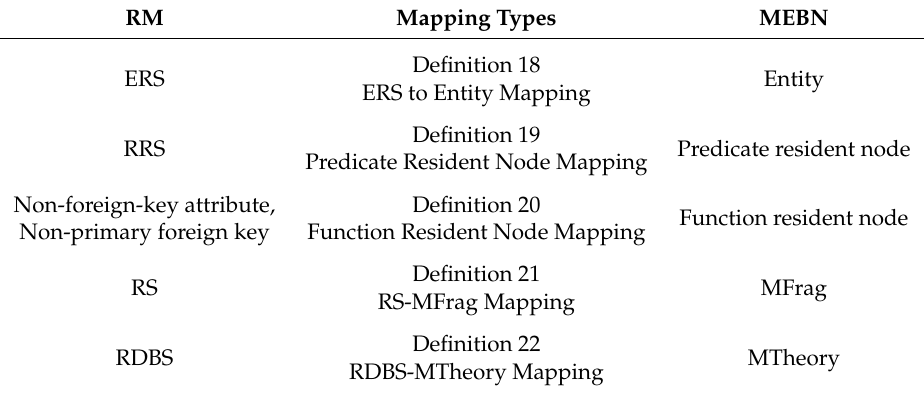
Table 8. Mapping types on